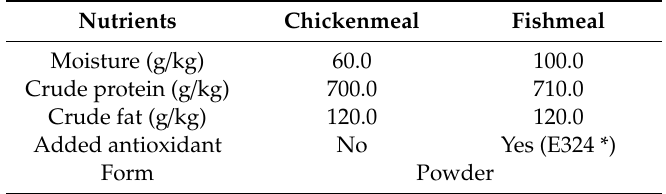
Table 1. Chemical composition of chickenmeal and fishmeal (as in basis, provided by supplier).